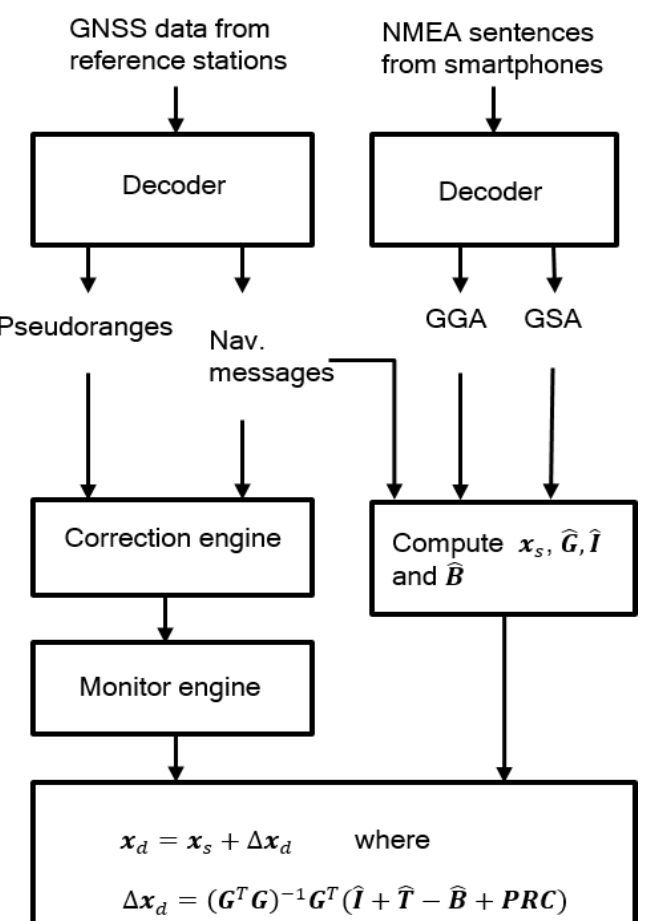
Figure 1. Flowchart of Differential Global Navigation Satellite System (DGNSS) based on NMEA messages.